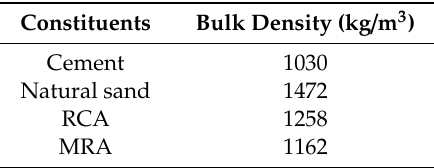
Table 2. Bulk density of the constituents